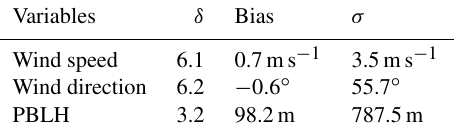
Table 2. Rank-histogram score ( δ ), biases and standard deviation ( σ ) of the 45-member ensemble for wind speed, wind direction and PBLH computed across 14 rawinsonde sites using daily